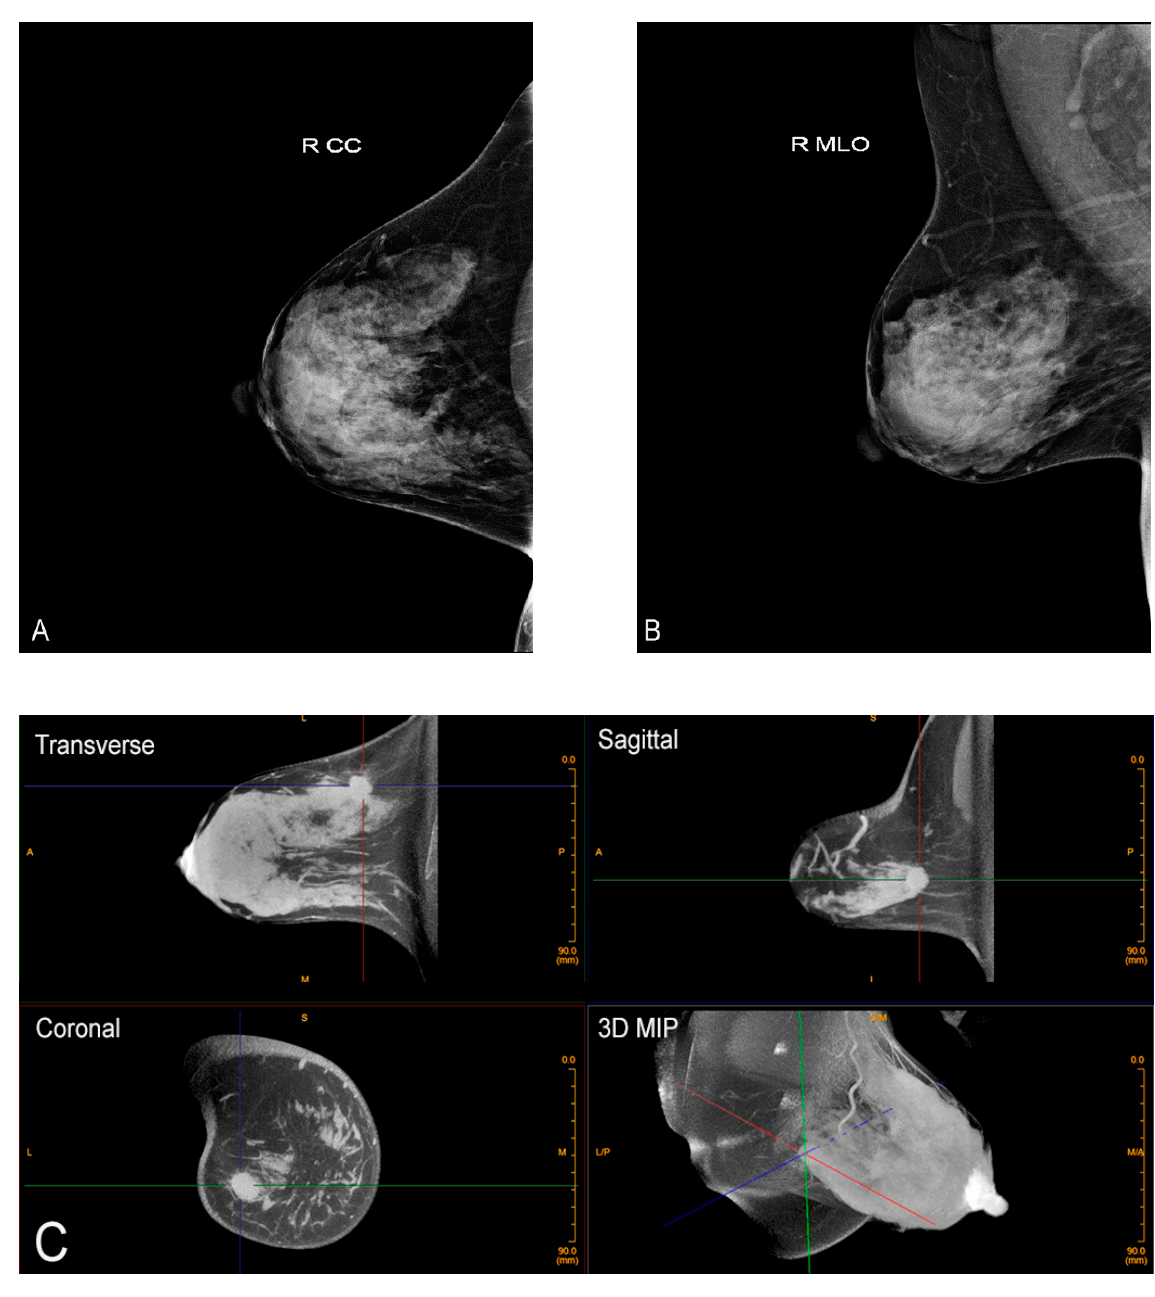
Figure 3. Advantage of CBBCT over mammography for imaging dense breast tissue. Bilateral CC ( A ) and bilateral MLO ( B ) views demonstrate dense breasts without focal findings consistent with a negative or BI-RADS 1 mammogram. ( C ) Post-contrast CBBCT demonstrates a mass denoted by guidelines that is easily recognized consistent with cancer.